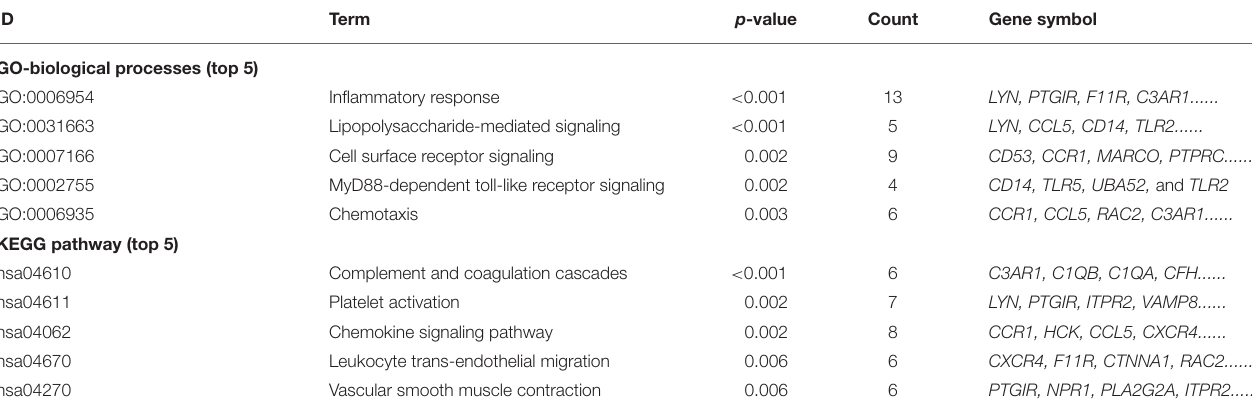
TABLE 1 | The significant GO biological processes and KEGG pathways enriched by